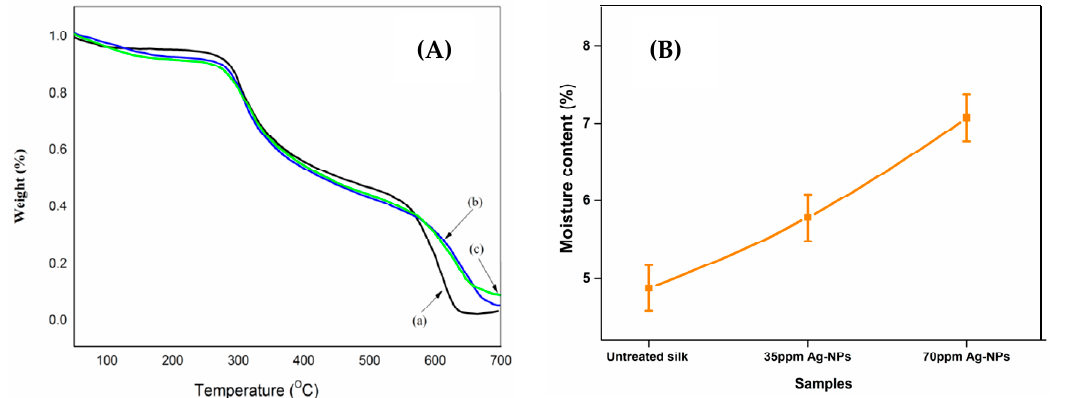
Figure 5. ( A ) Thermo-gravimetric analysis (TGA) curve: ( a ) control silk; and treated silk with ( b ) 35 ppm AgNPs and ( c ) 70 ppm AgNPs. ( B ) Moisture content (%).